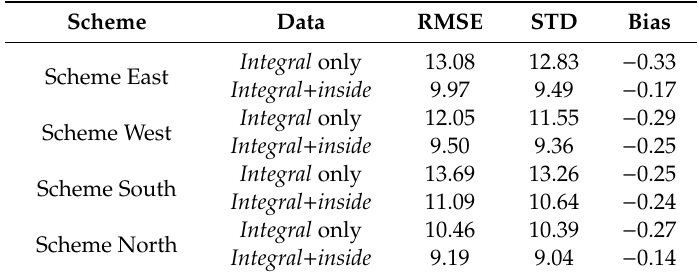
Table 3. Statistical results of the comparison of SWV between reconstructions and measurements for the four schemes (unit: mm).